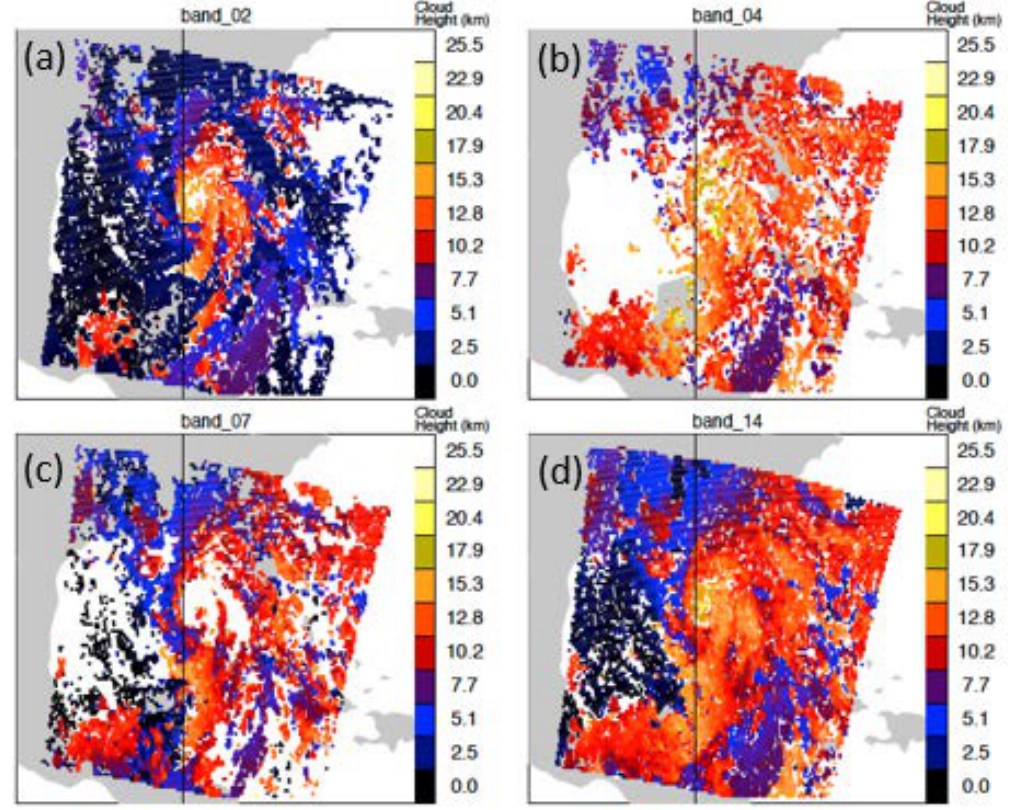
Figure 29. Distributions of the AMV height retrieval (chip size 32 × 32 km) for the four spectral bands (ABI bands 2, 4, 7, and 14 in panels ( a – d ) respectively). The vertical line is 87.5 ° W longitude.